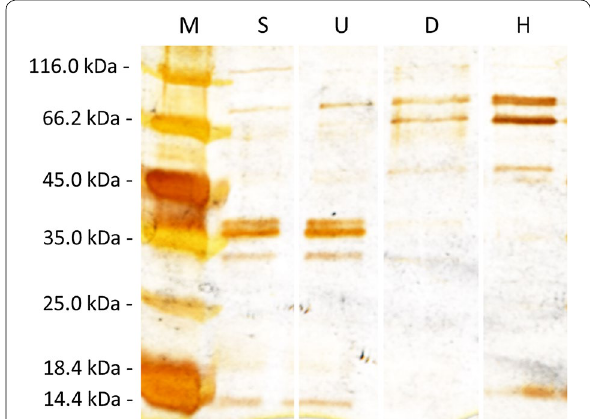
Fig. 2 SDS-PAGE of Lcc8 purification steps stained with silver under denaturizing conditions. M Pierce ™ unstained protein MW Marker, S supernatant, U ultrafiltration, D AEX (DEAE-Sepharose) and H HIC